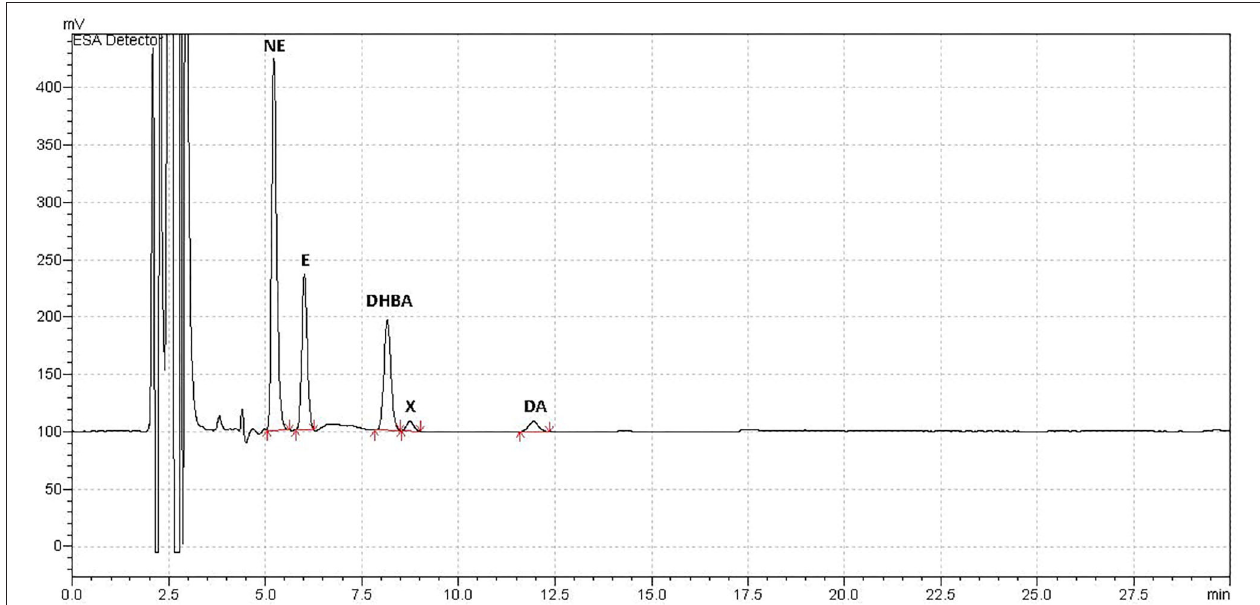
FIGURE 1 | Example Chromatograph. Example of typical chromatograph obtained using HPLC-ED for analysis of plasma catecholamine concentrations in a sample from adult female rats treated with an antipsychotic drug or vehicle. Catecholamine peaks were all well-separated with no peak overlap. Catecholamines measured were norepinephrine (NE), epinephrine (E), and dopamine (DA). The internal standard, added after plasma collection, was 3,4-dihydroxybenzylamine (DHBA). An unidentified peak (“X”) occurred at ∼ 8–8.5mins, which correlated with catecholamine levels, and may have been a